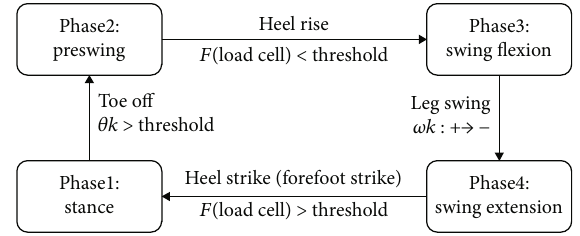
Figure 12: Finite state